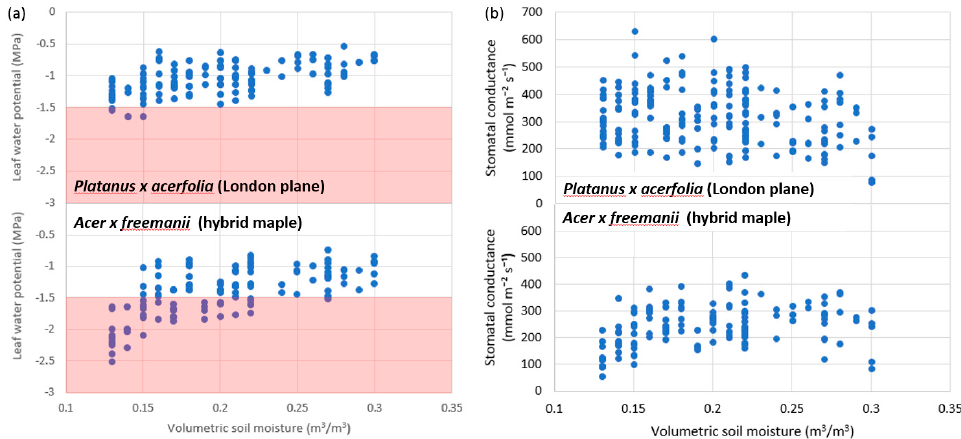
Figure 4. Relationship between soil moisture and ( a ) leaf water potential or ( b ) stomatal conductance for the two tree species investigated. The red shaded area denotes the water potential levels at which plant water stress typically occurs (>1.5 MPa [22]).